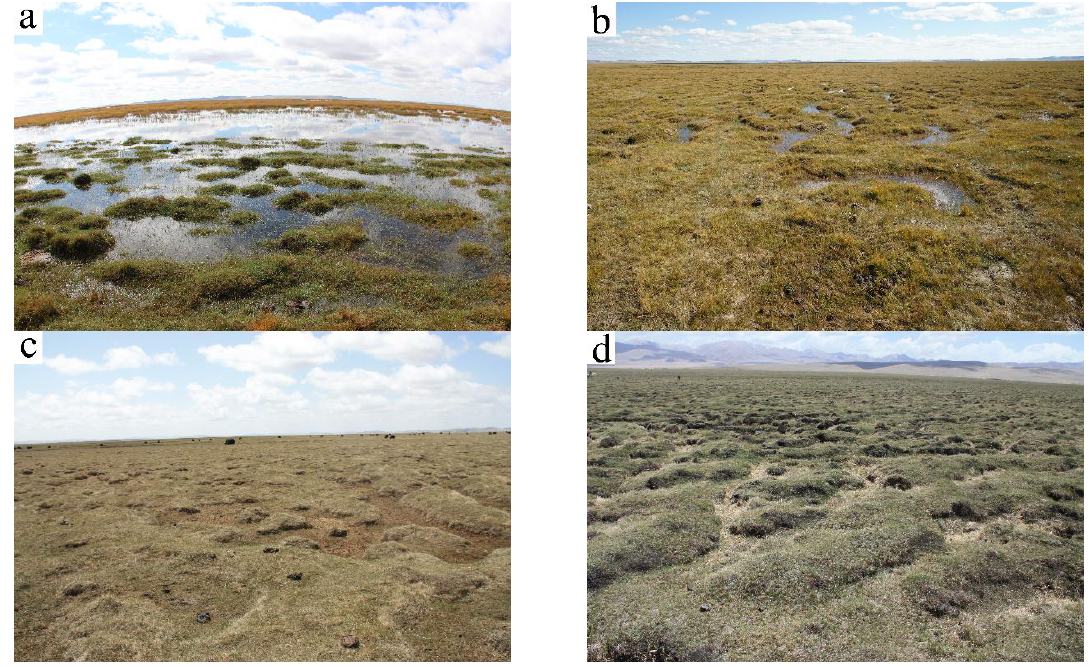
Figure 2. Photographs of the typical land cover types over the transect: ( a ) permanent wetland; ( b , c ) intermittent wetland in wet and dry condition; and ( d ) dry grassland.